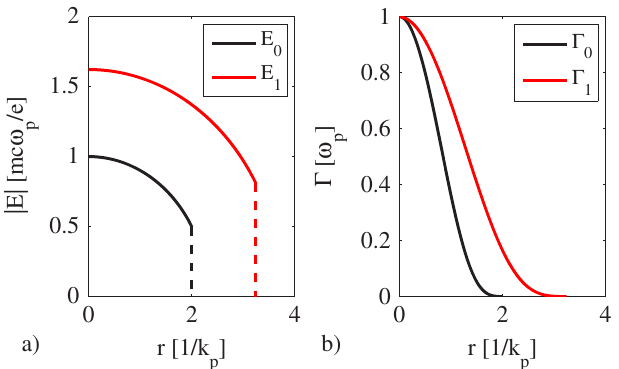
FIG. 2. (Color) (a) The magnitude of the electric field along a (cid:2) contour with z (cid:2) ct ¼ (cid:2) 2 =k p on axis, E 0 ; and with z (cid:2) ct ¼ (cid:2) 3 : 244 =k E p on axis, 1 . The radial extent of a contour increases as it moves farther back in the bubble. (b) The ionization rate of helium for E 0 at n p ¼ 8 : 0 (cid:1) 10 23 m (cid:2) 3 , (cid:3) 0 , and for E 1 at n p ¼ 2 : 7 (cid:1) 10 23 m (cid:2) 3 , (cid:3) 1 .